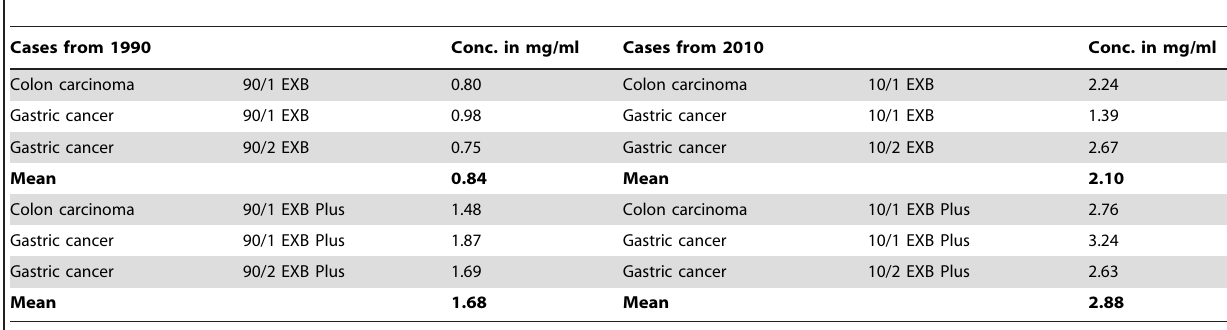
Table 1. Protein yield from long-term stored FFPE tissue